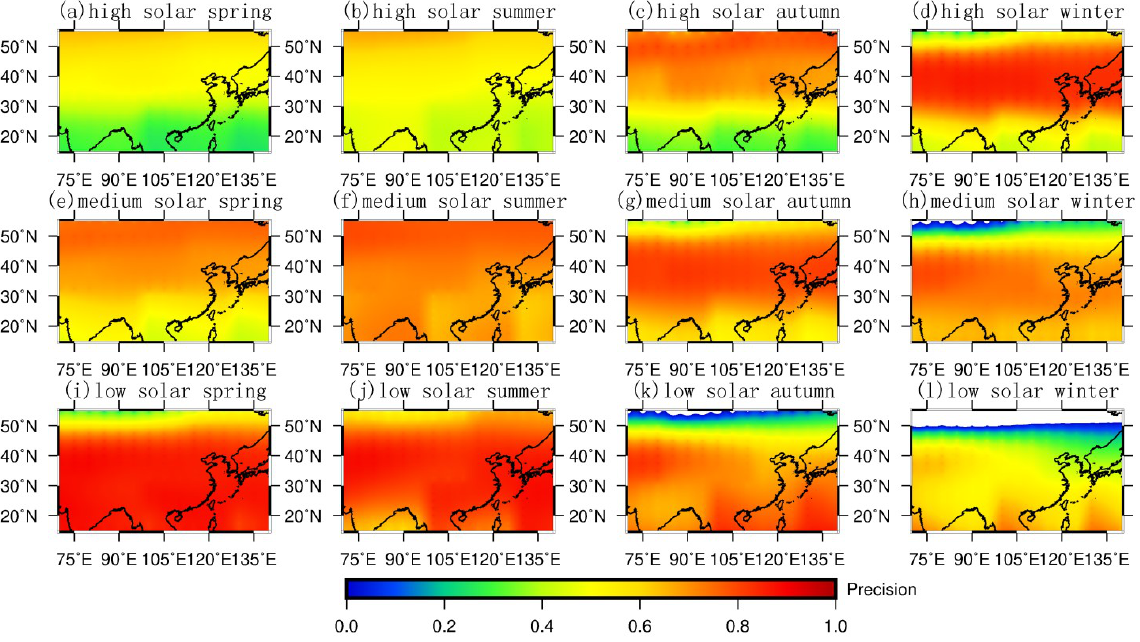
Fig.4 Season average accuracy of Klobuchar model during high, medium and low solar